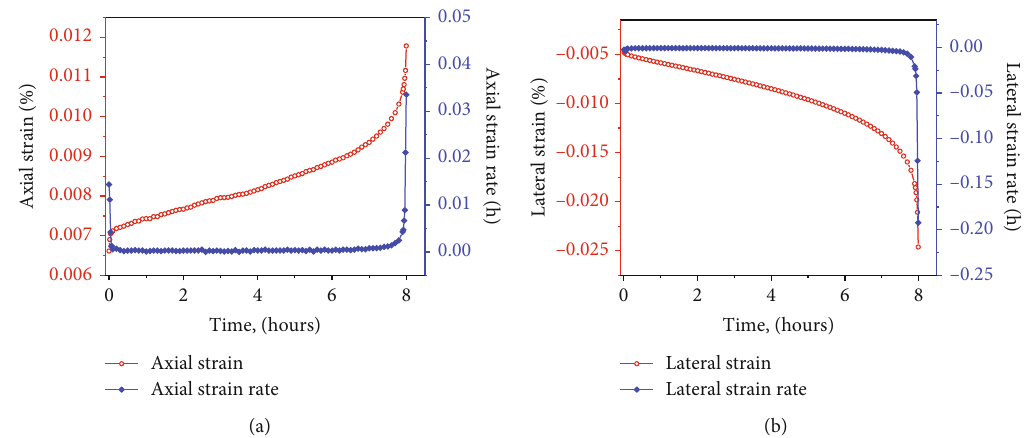
Figure 14: Creep strain and the associated creep strain rate of the mudstone interlayer at the fi nal stress level.